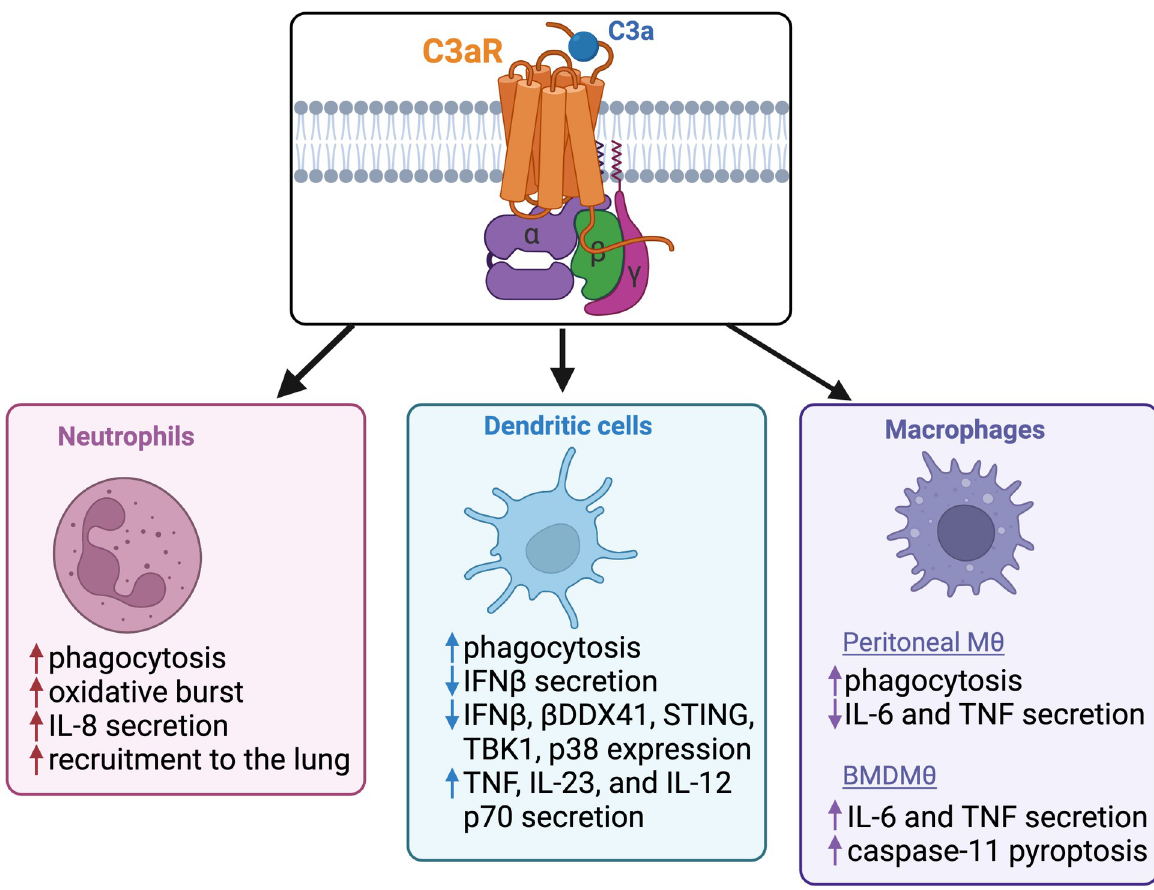
Fig 1. Schematic of C3aR-dependent innate immune cell function during bacterial infections.